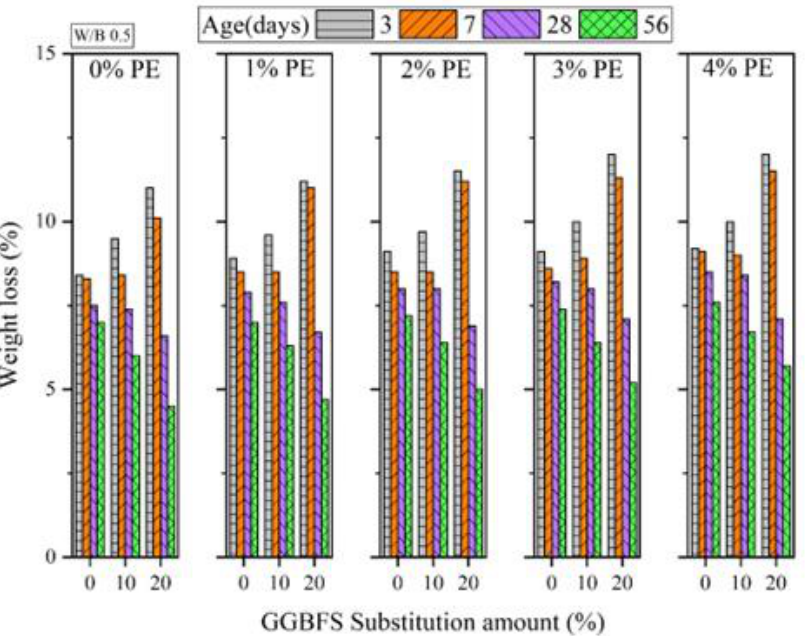
Figure 12. Weight loss of cement mortars with the addition of different ratios of waste PE and GGBFS replacement.